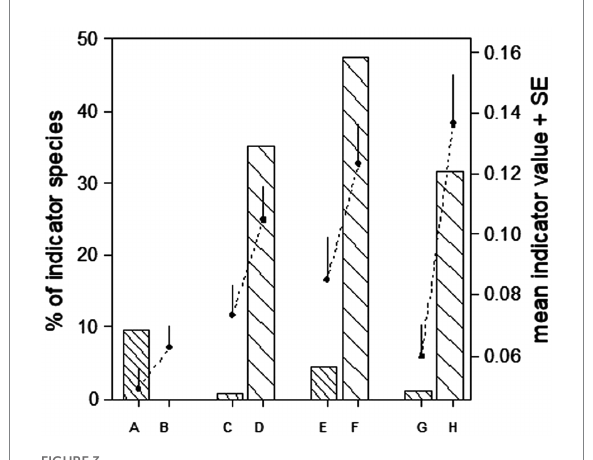
FIGURE 3 Percentage of significant indicator species per habitat type across regions and years (bars), and mean indicator value (+ 1SE) of all species (black dots). A: conventional meadow, B: BPA meadow, C: conventional meadow, D: BPA orchard, E: production field, F: BPA hedge, G: crop field, H: wildflower strip BPA.